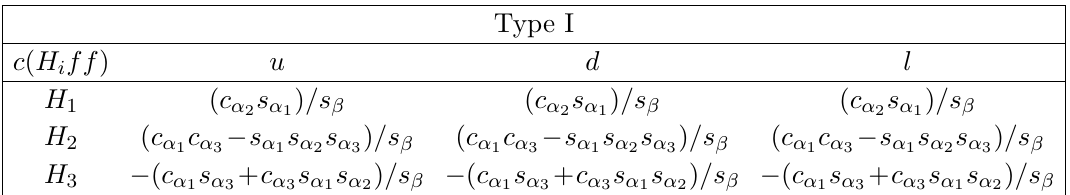
Table 2 . The e(cid:11)ective Yukawa couplings c ( H i ff ) of the N2HDM Higgs bosons H i , as de(cid:12)ned in eq. (2.20) for Type